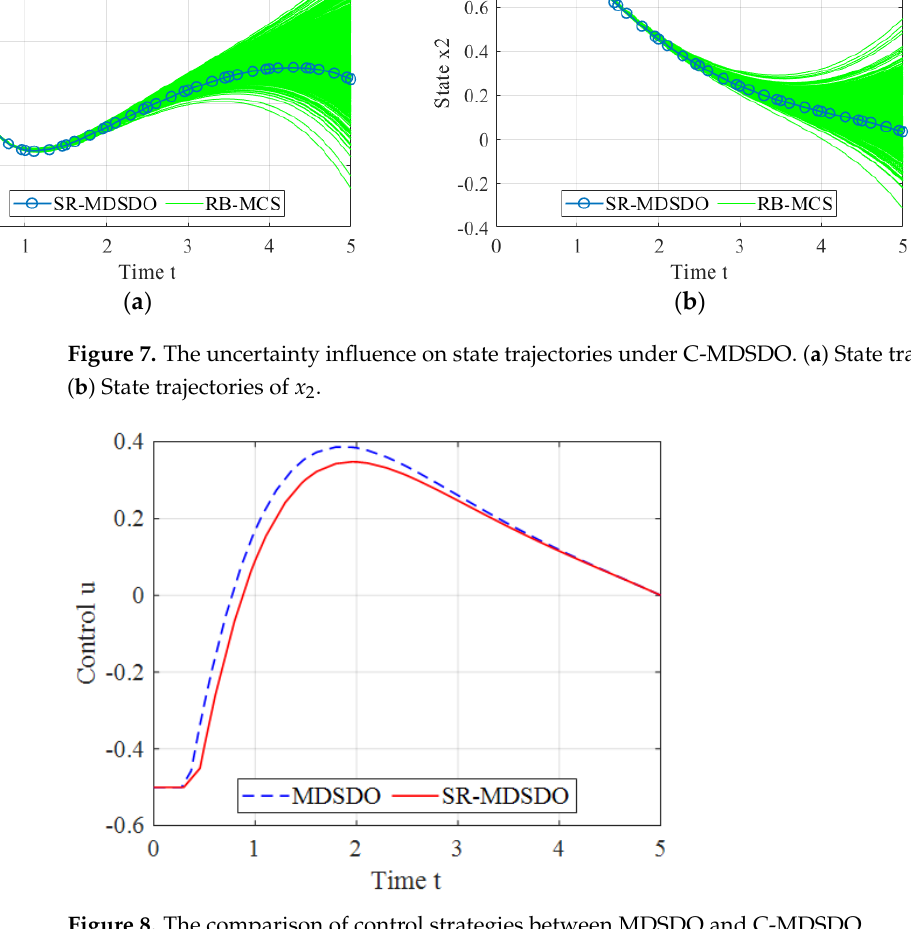
Table 2. The optimization result comparison between MDSDO and C-MDSDO. 415